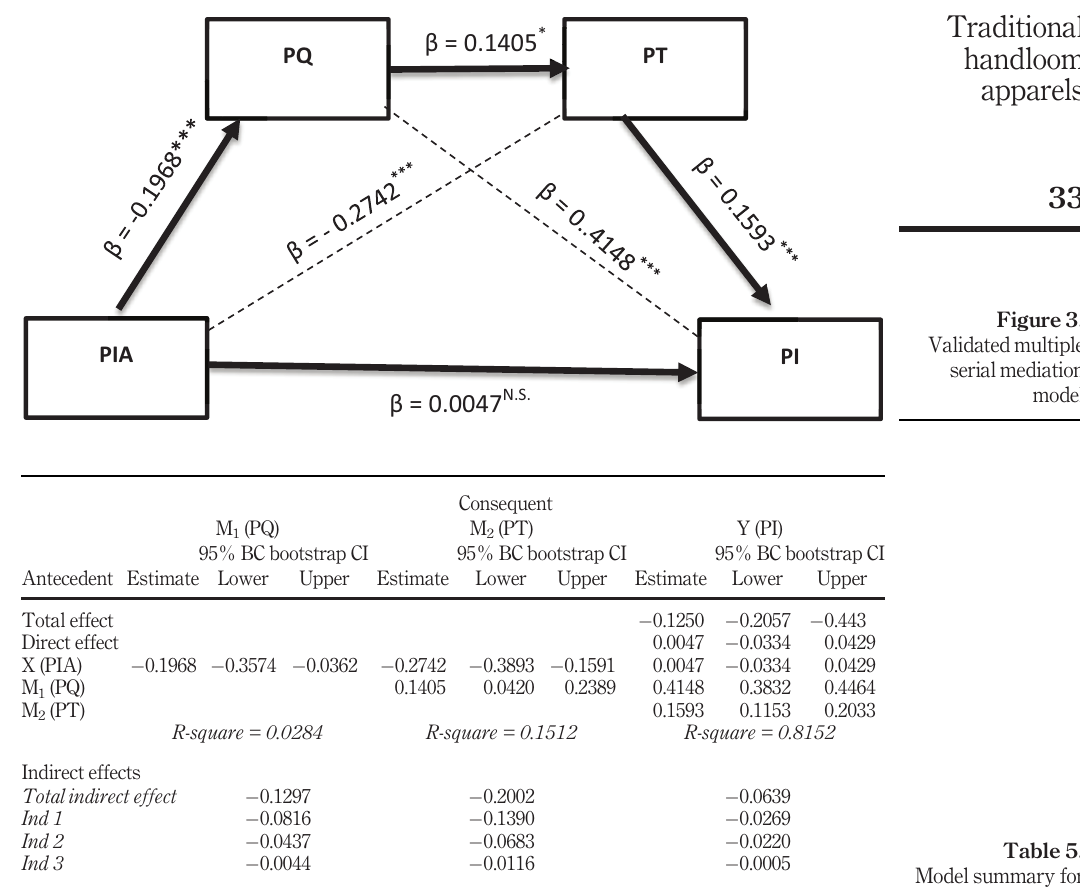
Table 5. Model summary for